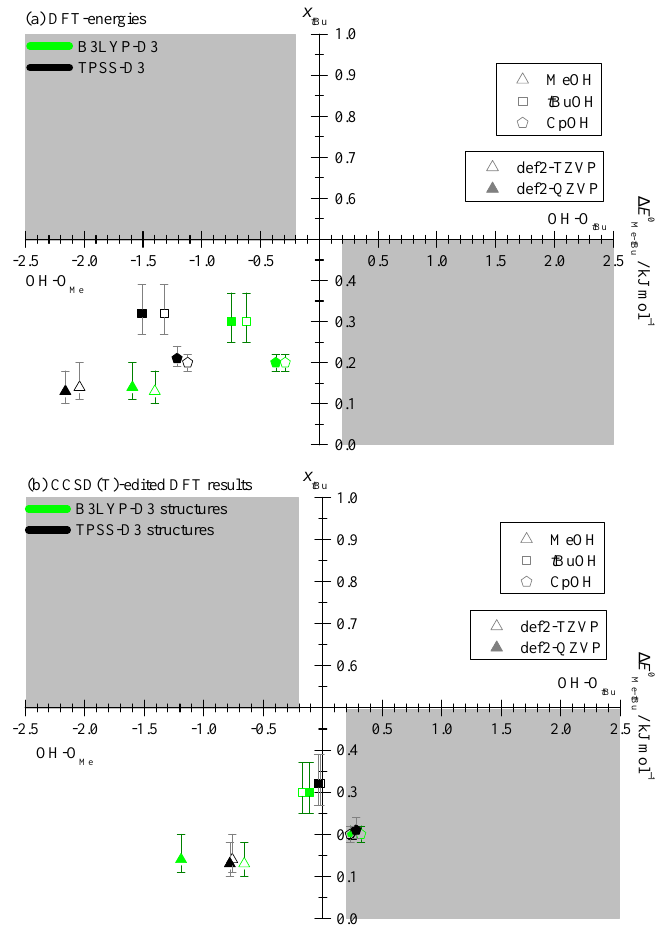
Figure 6. Experimental t Bu docking fraction x t Bu = c t Bu / ( c t Bu + c Me ) (based on 95% confidence intervals and the mean value for the ratio I Me / I t Bu from Table 1 and Tables S7 and S8) plotted against the computed ZPVE corrected energy differences E 0 . Grey areas indicate inconsistency between Me − t Bu experiment and theory, when allowing for an estimated anharmonic ZPVE error of ± 0.2kJmol − 1 and assuming correct cross section ratios form the respective theoretical model. ( a ) DFT energies, where all models predict the correct qualitative docking preference, but the correlation of energy and abundance is non-uniform. ( b ) As in ( a ), but with the electronic energy being replaced by the corresponding DLPNO-CCSD(T) value (see Section